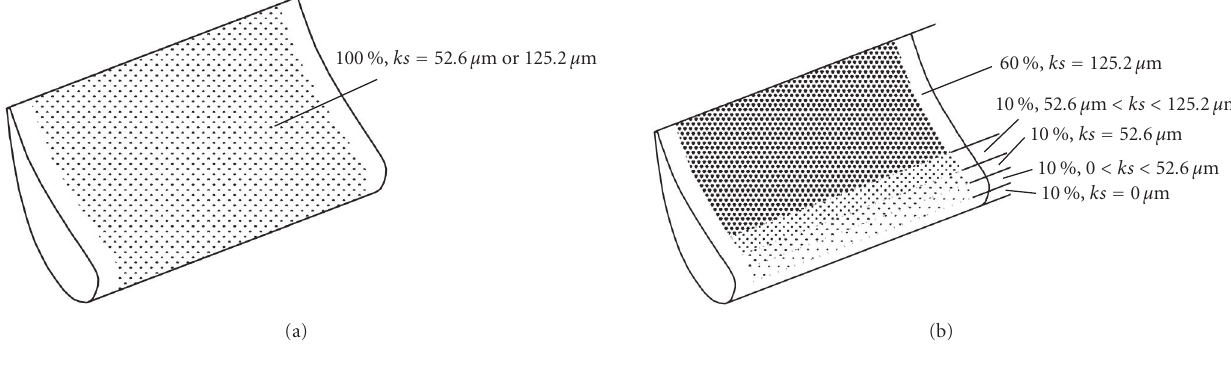
Figure 2: Test airfoils with rough surfaces. (a) Airfoil with uniform roughness. (b) Airfoil with variable roughness on the pressure side.